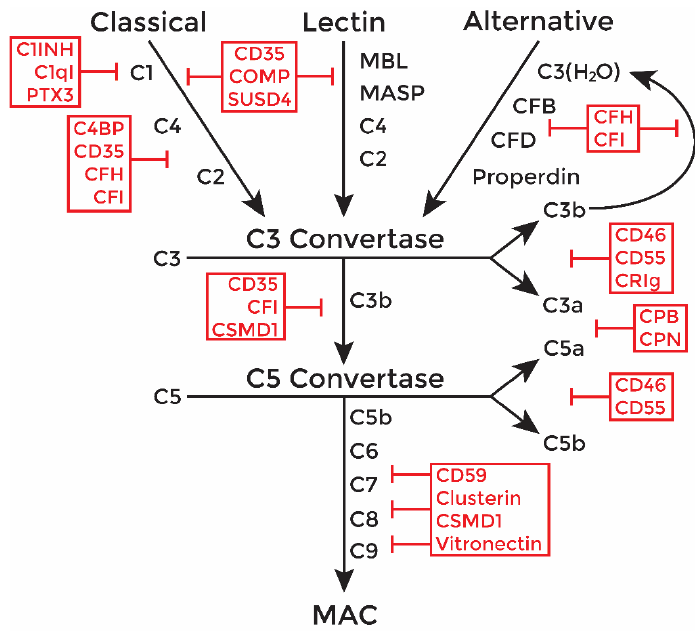
Figure 1. The complement system. Complement can be activated through the classical (by antibody binding), lectin (by bacterial oligosaccharides and acetylated residues), or alternative (spontaneously or by other pathway activation) pathways. All three pathways converge at the formation of a C3 convertase, which then forms the C5 convertase, which cleave C3 and C5 into their respective anaphylatoxins (C3a, C5a) and their pathway components (C3b, C5b). Complement terminates with assembly and insertion of the membrane attack complex (MAC), an intermembrane pore that causes cytolysis of the target cell. Complement cascade components are in black, and inhibitors are in red. C1INH: C1 inhibitor (SERPING1). C1qI: C1q inhibitor. C4BP: C4 binding protein. CD35: complement receptor 1 (CR1). CD46: membrane cofactor protein (MCP). CD55: decay accelerating factor (DAF). CFH: complement factor H. CFI: complement factor I. COMP: cartilage oligomeric matrix protein. CPB: carboxypeptidase B. CPN: carboxypeptidase N. CRIg: complement receptor of the immunoglobulin superfamily. CSMD1: CUB and sushi domain protein 1. PTX3: pentraxin 3. SUSD4: sushi domain-containing protein 4.